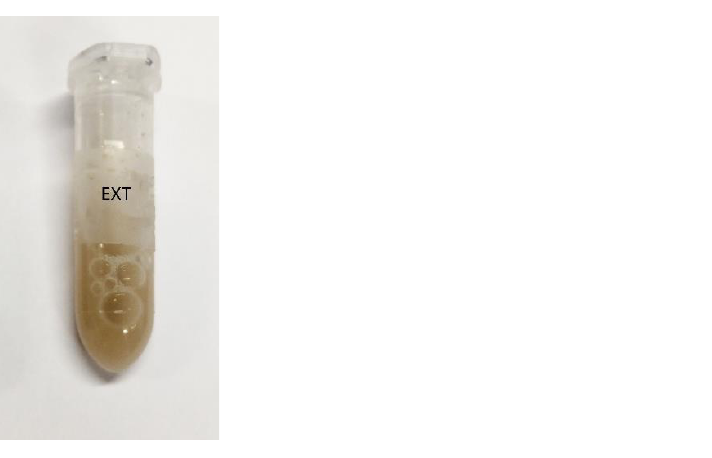
Figure 3. Caecum content stained with Lugol´s iodine. On the left is a sample of group PEL, stained entirely blue, and on the right a sample of group EXT.